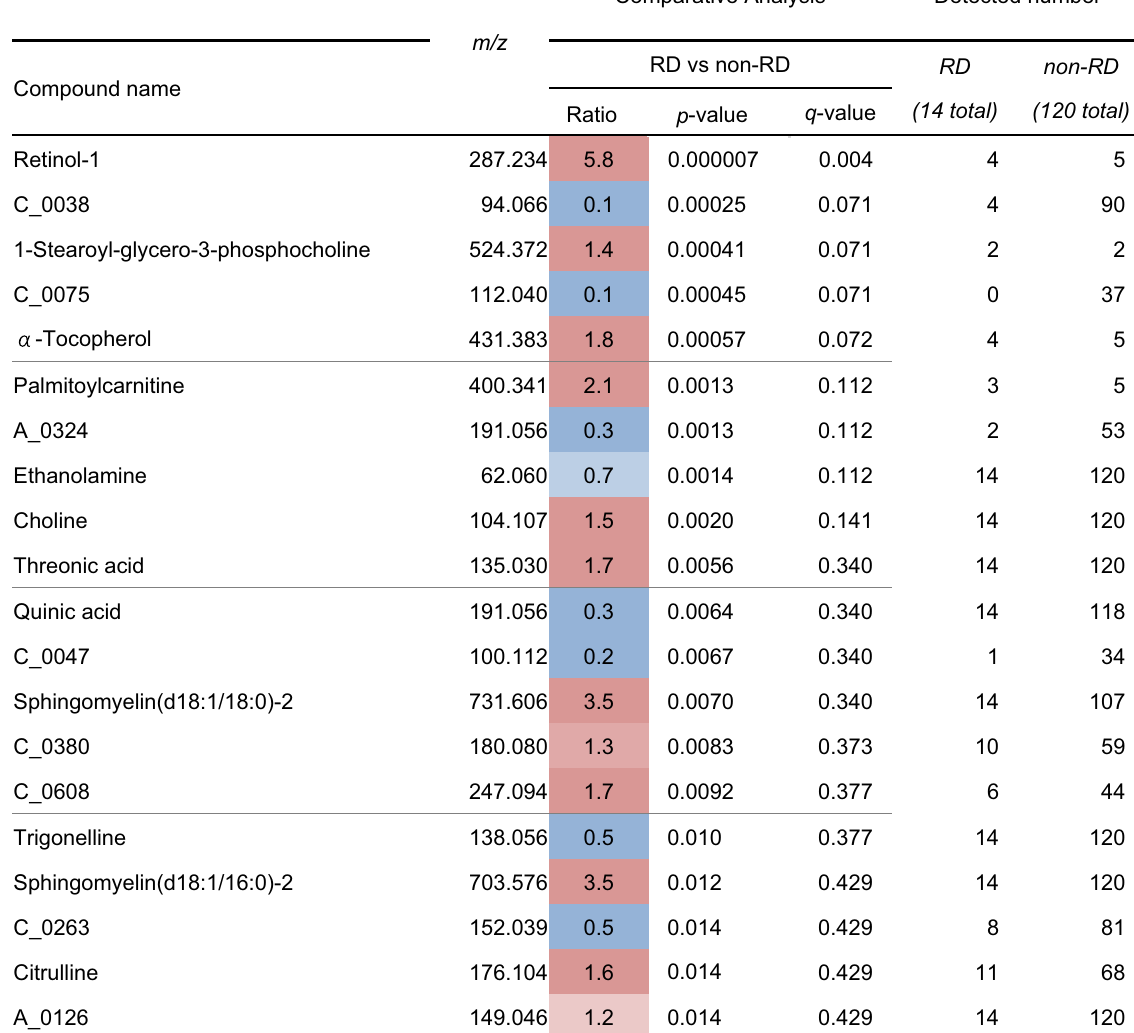
Table 1. Logistic analysis for rapid decliner using urinary metabolome. RD rapid